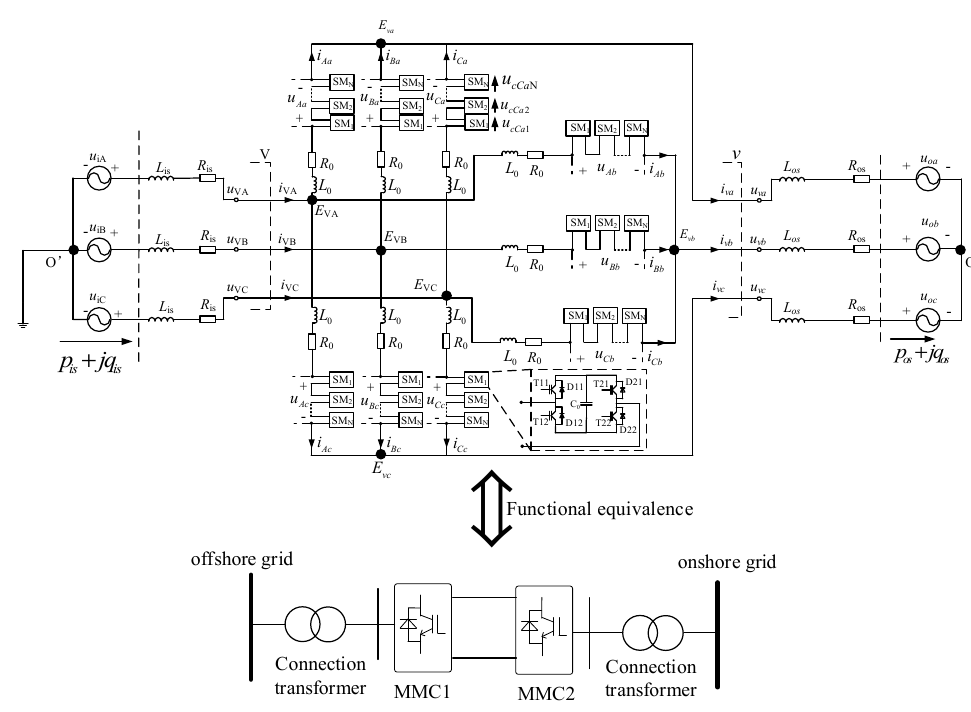
Figure 3. Topology and functional equivalence of